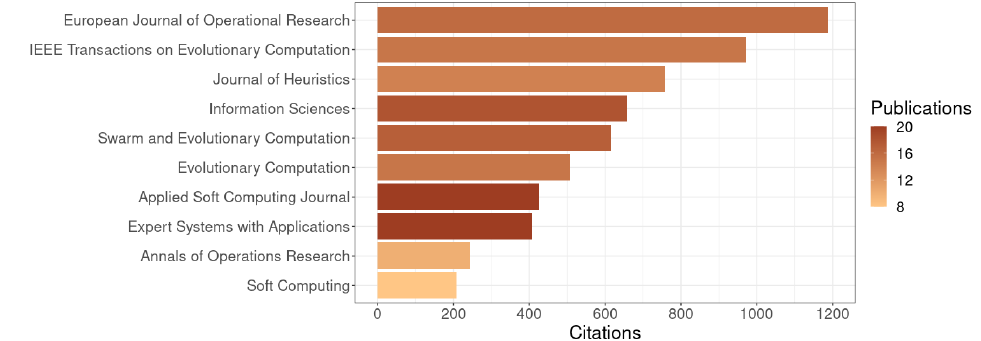
Figure 3. Distribution of citations and number of documents of the top ten journals with the most citations for documents on hyper-heuristics (obtained on 5 April 2022).